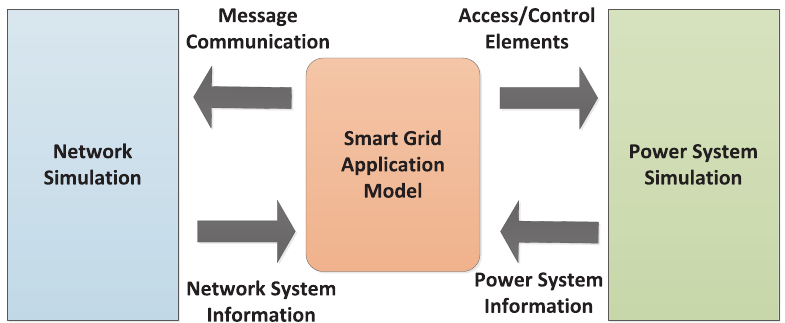
Figure 1. The conceptual representation of the proposed